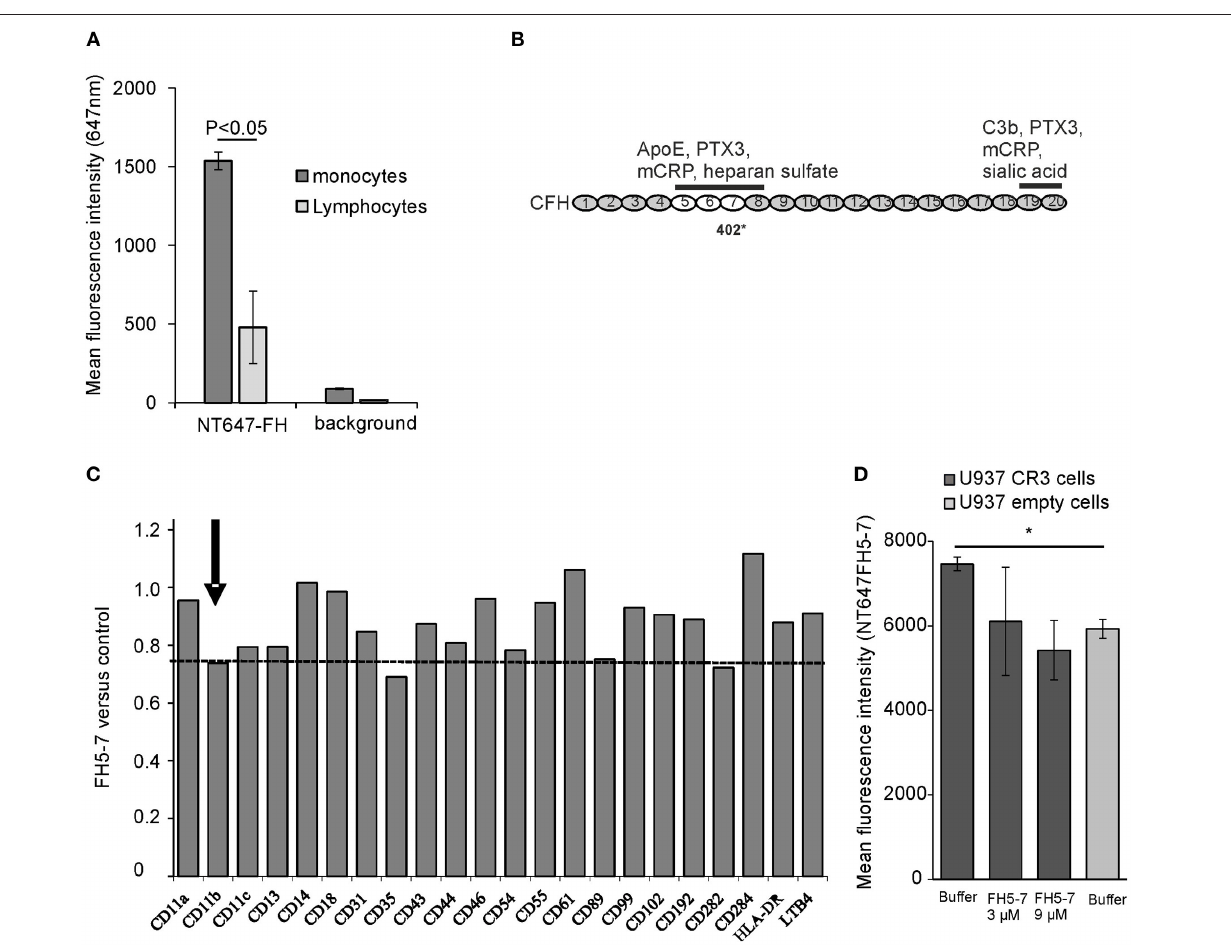
FIGURE 1 | Factor H binding to peripheral blood leukocytes. (A) Peripheral blood mononuclear cells were incubated with NT647-labeled FH and the mean fluorescence intensities were analyzed by flow cytometry ( n = 3). (B) Schematic structure of the full length FH and the location of domains 5–7 that interact with apoE. The binding sites of different ligands, apoE, pentraxin3 (PTX3), monomeric C-reactive protein (mCRP) and heparin sulfate, and the common polymorphic Y402H site on domain 7 are shown. (C) Screening of FH5-7 binding by a panel of antibodies directed against various receptors and surface molecules on monocytes. Peripheral blood monocytic cells were preincubated for 30min with or without 12 µ g/ml of FH5-7 prior adding 2 × 10 5 cells cells/well in a 96-well plate with FITC-, APC- and/or PE-labeled antibody. Mean fluorescence intensities were calculated from the gated cells using flow cytometry. Inhibition of antibody binding was calculated by dividing the mean fluorescence of FH5-7 treated cells by PBS treated cells (FH5-7 vs. control). The CD11b part of CR3 dimer is marked. The dashed line shows the level of anti-CD11b binding in the presence of FH5-7 ( < 0.8) compared to binding of the antibody without FH5-7 (1.0). (D) CR3 expressing and empty U937 mononuclear cells were incubated with NT647 labeled FH5-7 in the presence or absence of unlabeled FH5-7 (x-axis). Statistical significance between multiple samples was calculated using one-way ANOVA supplemented with non-parametric Tamhane’s post-hoc multiple comparison test. Error bars indicate SD. * = p <